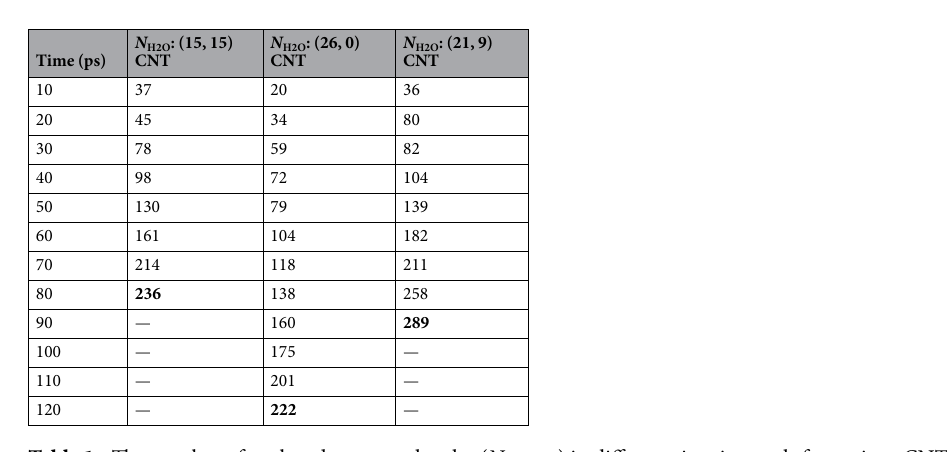
Table 1. The number of enclosed water molecules ( N water) in different time intervals for various